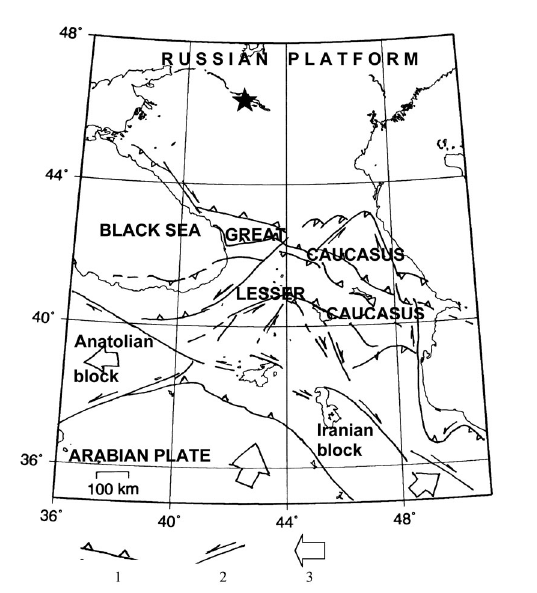
Fig. 9. Tectonic setting of the 22 May 2001 Salsk earthquake from Tatevossian et al. (2002). Tectonic scheme from Rebai et al. (1993) with simplifications: 1 – reverse faults (triangles point to upthrown wing); 2 – strike- slip faults (arrows show direction of motion); 3 – plate motion